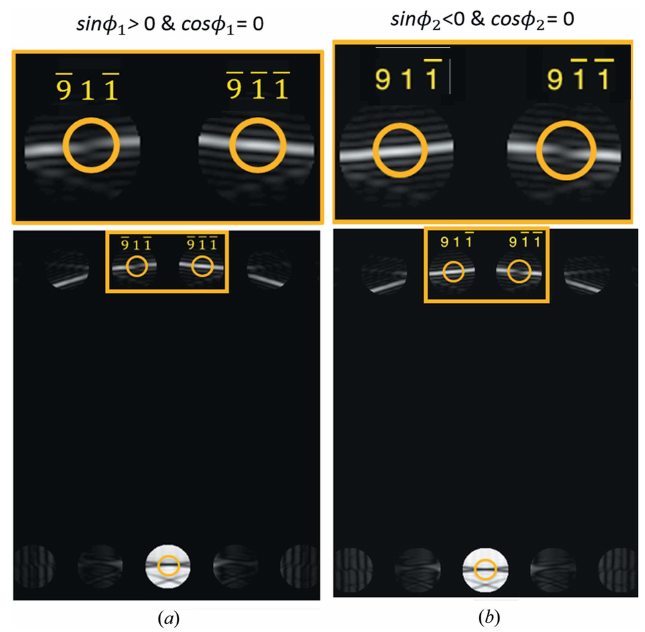
(cid:4) ’ þ ’ = 103 (cid:3) . For the 2 ; 3 ; 1 1 ; 2 ; 1 3 ; 1 ; 0 (cid:4) ’ þ ’ = (cid:4) 103 (cid:3) . 2 ; 3 ; 1 1 ; 2 ; 1 3 ; 1 ; 0